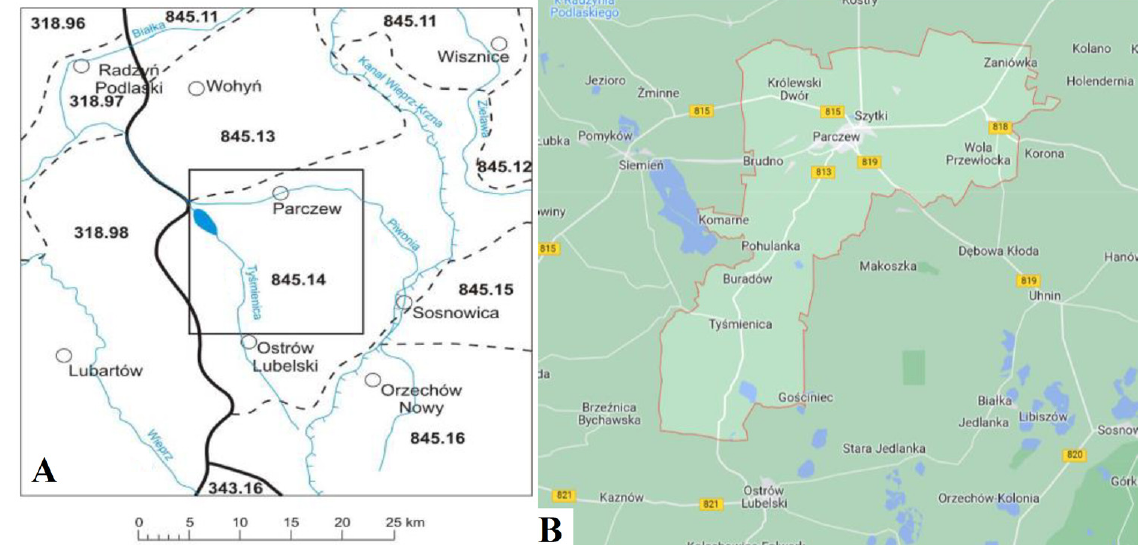
Figure 1. Location of Parczew against the background of physico-geographical units: ( A ) Province: East Baltic–Belarusian Lowlands, sub-province: Polesie; ( B ) Location on the map of the Parczew commune in the Western Polesie, which is the part of the East Baltic–Belarusian Lowland province.